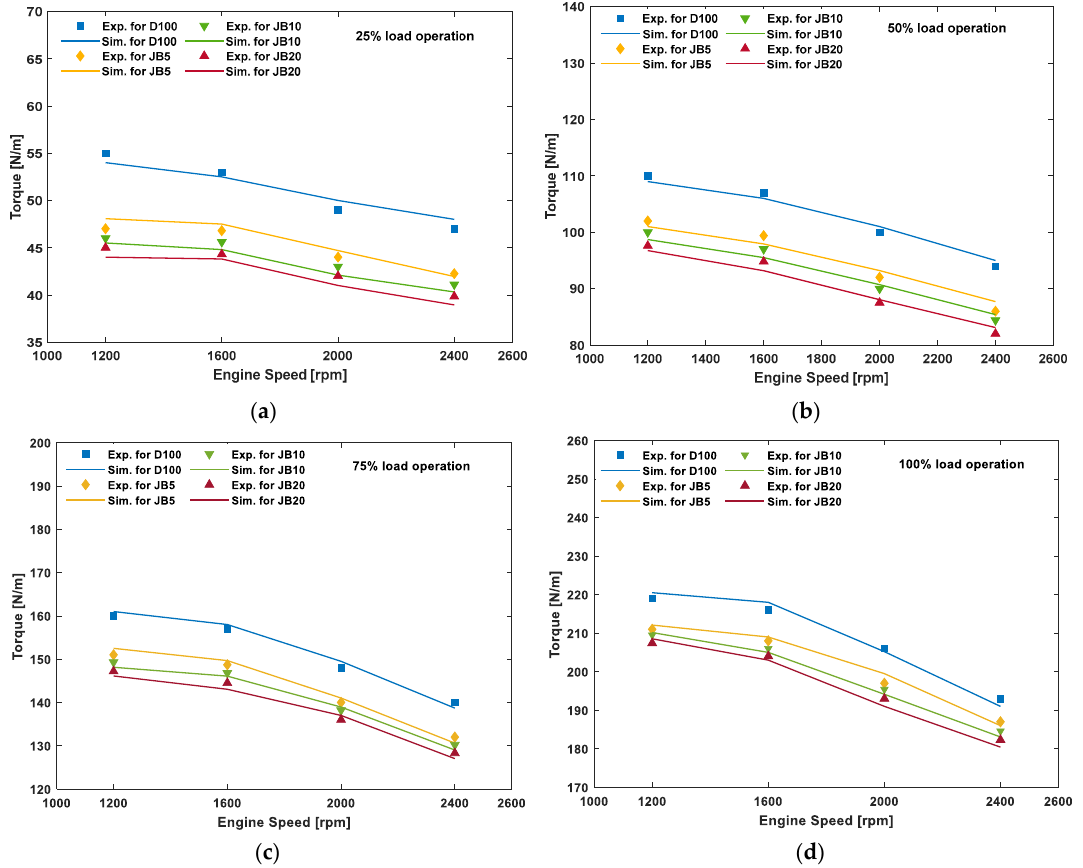
Figure 4. Comparison between simulation and experimental results of Torque for diesel and JB blends at ( a ) 25%, ( b ) 50%, ( c ) 75% and ( d ) 100% loading conditions. Furthermore, Figure 4b – d represents a comparison of simulation and experimental results at all speeds under 50%, 75%, and 100% loading conditions utilizing pure diesel and all three jojoba – diesel blends. It is to be noted that the simulated torque value is pro- vided directly from the model. In contrast, the experimental values were measured using Dyno Dynamics (450DS) software interfaced with the test PC. A good coincidence exists, with all simulated and measured points lying very close in this diagram. Compared to diesel and jojoba – diesel blends, higher torque showed because of higher calorific value, lower density, and viscosity [66]. Among three percentages (5%, 10%, and 20%) of jojoba blends, the torque value at JB5 is higher than JB20. As it is well known for this kind of engine, both the simulation and experimental curve show the same trends; that is, torque decreases with an increase in engine speed because of volumetric efficiency and friction loss [67]. A good agreement was found between the predicted and measured values of torque. The minimum error was 4.7% at 100% and 1600 rpm for JB5, and the maximum error was 19.2% at 1200 rpm and 25% loading operation for JB10. Figure 5a examines the variation of calculated and experimental BTE values for D100 and all three jojoba – diesel blends at 25% load with different speeds. It showed that BTE increases with speeds up to 1600 rpm and then decreases with increasing speeds because of insufficient air in the cylinder and compression airdrop, hence the incomplete combus- tion of fuel [30,68]. Figure 5a – d compares predicted and experimental values at different speeds at 25%, 50%, 75%, and 100% loading conditions for all three (5%, 10%, and 20%) jojoba – diesel blends. The curves showed that the BTE decreases with increasing blends because of higher calorific value and lower fuel consumption. In contrast, BTE increases with speed at a certain level and then decreases due to lower viscosity, higher volatility, and the re- duction in heat losses, leading to an increase in the fuel – air mixer [69,70]. More fuel injec- tion pressure at full load conditions causes a negligible effect on the viscosity, leading to maximum combustion and increasing BTE [71]. Figure 5 shows that BTE decreases with increased jojoba blends from JB5 to JB20 in all the graphs. The higher BTE is observed at JB5 compared to JB10 and JB20 due to higher calorific value, less fuel consumption, lower viscosity, and higher volatility, leading to air – fuel mixing [72,73]. Figure 5 represents a good agreement between the simulated and measured values of BTE at all operating con- ditions. The minimum error was 3.4% at 100% and 2000 rpm for D100, and the maximum error was 18.3% at 1200 rpm and 25% loading operation for JB10.